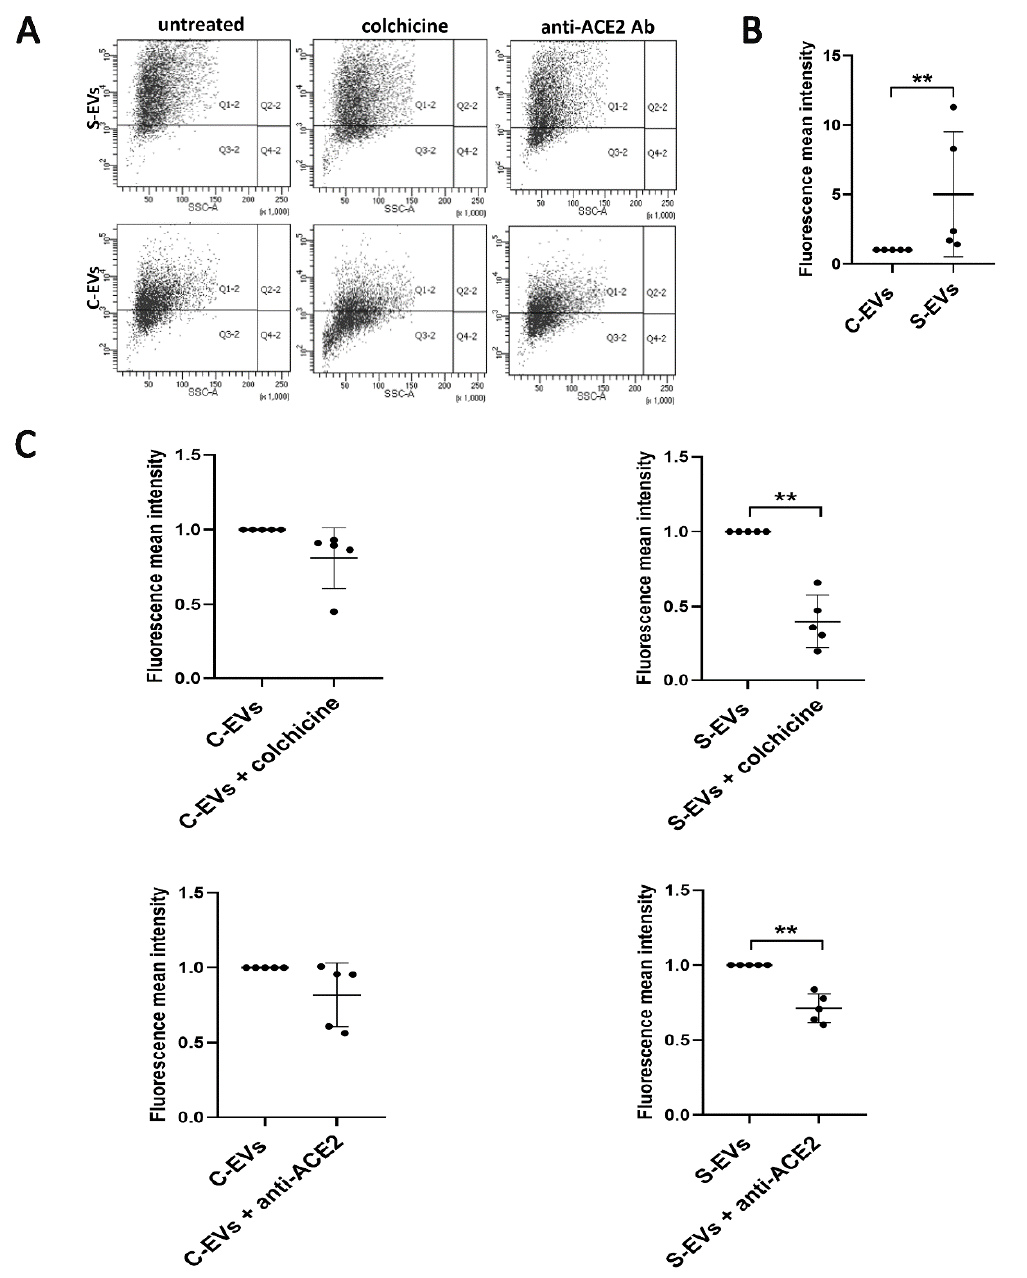
Figure 6. Effect of colchicine and anti-ACE2 blocking antibody on the EV uptake by HUVEC. ( A ) Representative flow cytometry dot plots of S-EV or C-EV uptake without treatments (untreated) or with colchicine 150 µM (S/C-EVs colchicine) or anti-ACE2 20 µg/mL (S/C-EVs anti-ACE2 Ab). ( B ) Fluorescence mean intensity of all the positive events obtained by cytofluorometric analysis. Data were normalized to the respective uptake control (S-EVs or C-EVs), set as one, used as a reference sample for each experiment. For the comparison, C-EVs vs. S-EVs data were normalized to the C-EVs. The unpaired t -test was performed after the normalization for C-EV vs S-EV uptake with ** p < 0.01. ( C ) Fluorescence mean intensity of all the positive events obtained by the cytofluorometric analysis. Data were normalized to the respective uptake control (S-EVs or C-EVs), set as one, used as a reference sample for each experiment. For the comparison EVs vs. EVs + colchicine or EVs + anti-ACE2, data were normalized to the EVs. The paired - t -test was performed after the normalization for EVs vs. EVs + colchicine or EVs + anti-ACE2 with ** p <0.01. The graphs show the average of at least five independent experiments ± SD.